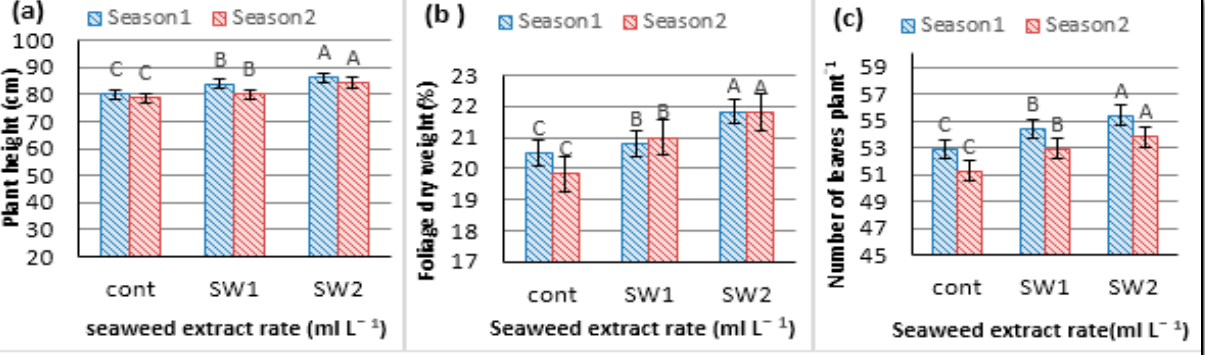
Figure 2. Vegetative growth parameters (means ± SE) of globe artichoke as affected by the application of seaweed extract rate (Control: without, SW 1 : 5 and SW 2 : 10 mL L − 1 ) on ( a ) Plant height (cm); ( b ) Foliage dry weight (%) and ( c ) Number of leaves plant − 1 . Letters in the figures indicate that the mean ± SE treatments with the same letters were not significantly different according to Duncan’s multiple range test for p < 0.05.